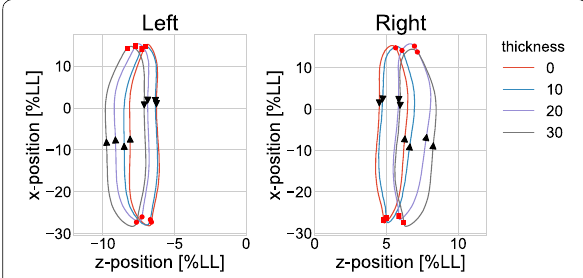
Fig. 7 Horizontal knee relative positions to pelvis during running. These positions described as percentage of leg length (%LL). The red circles and the red squares represent right and left heel strikes, respectively. The arrows represent the direction of motions. This figure demonstrates that runner with 20 mm thick and 30 mm thick blocks makes knees shift in lateral direction for avoiding blocks’ collision